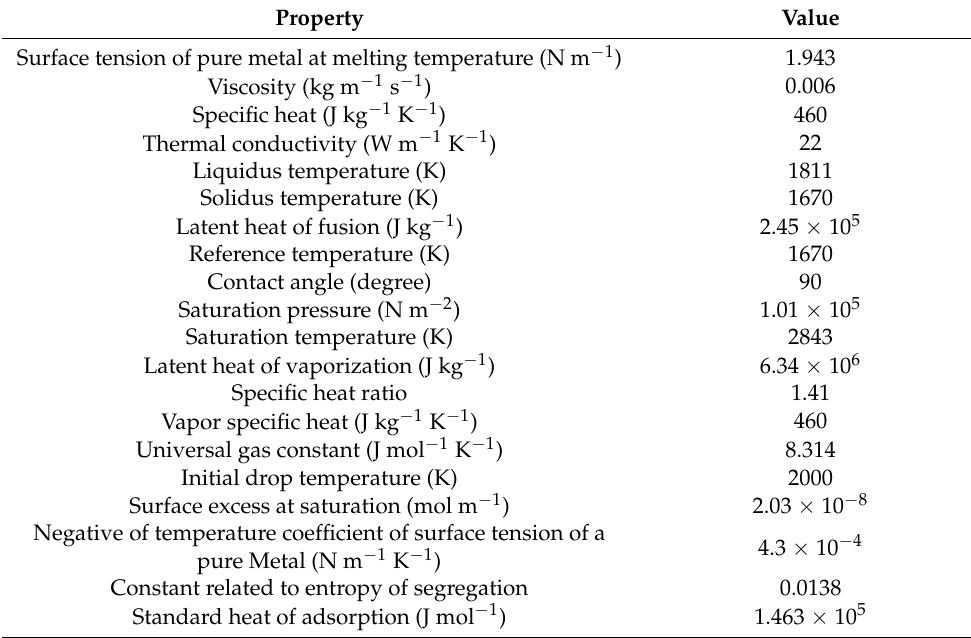
Table 2. Data related to surface tension used in the numerical